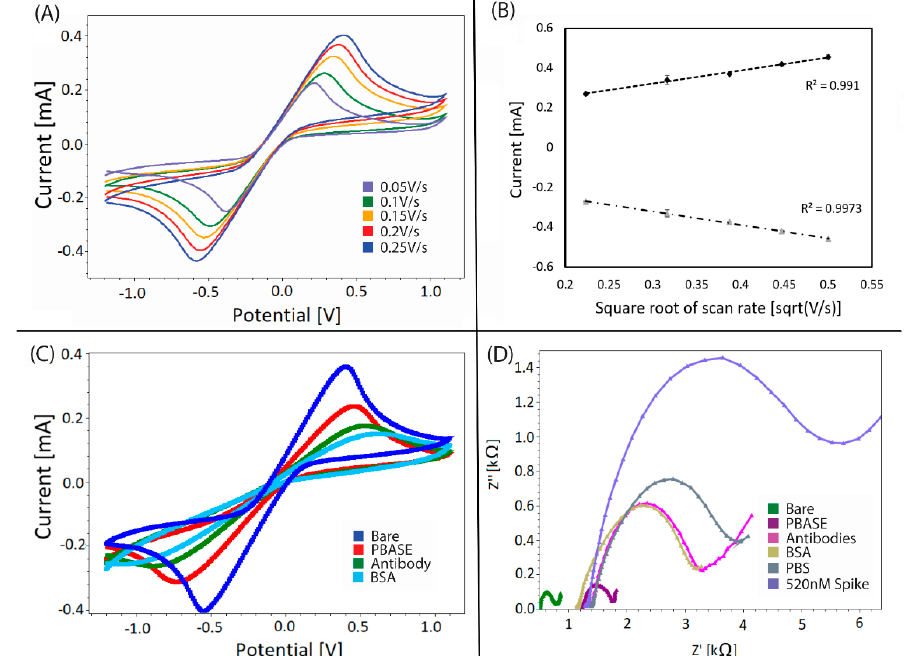
Figure 2. Diffusion ‐ controlled electrochemical characterization ( A ) Cyclic voltammograms of the Figure 2. Diffusion-controlled electrochemical characterization ( A ) Cyclic voltammograms of the functionalized electrode functionalized electrode as a function of the square root of scan rate, ( B ) Randles–Sevcik plot of as a function of the square root of scan rate, ( B ) Randles–Sevcik plot of peak current versus square root of scan rate. peak current versus square root of scan rate. Electrochemical characterization of electrode func ‐ Electrochemical characterization of electrode functionalization. ( C ) Nyquist plot and ( D ) Cyclic voltammograms of each tionalization. ( C ) Nyquist plot and ( D ) Cyclic voltammograms of each functionalization step. functionalization